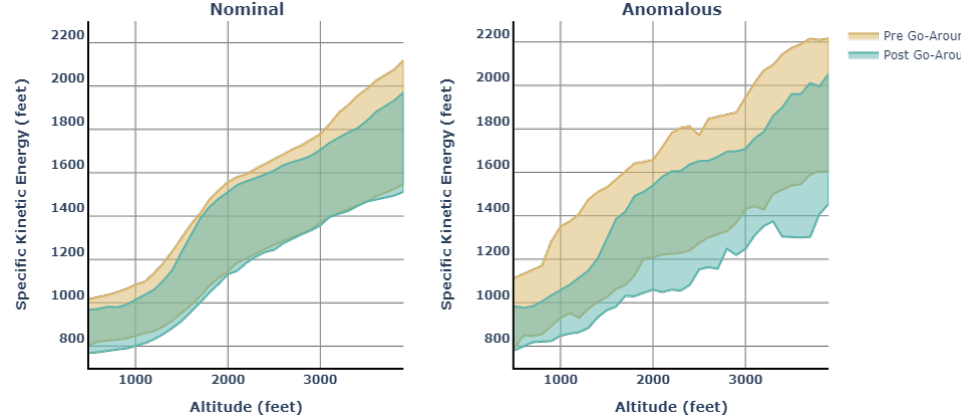
Figure 11. Comparison of specific kinetic energy for the approach prior to go-around execution and second approach for the actual landing. In this figure, the altitude is plotted on the x -axis, which differs from Figures 9 and